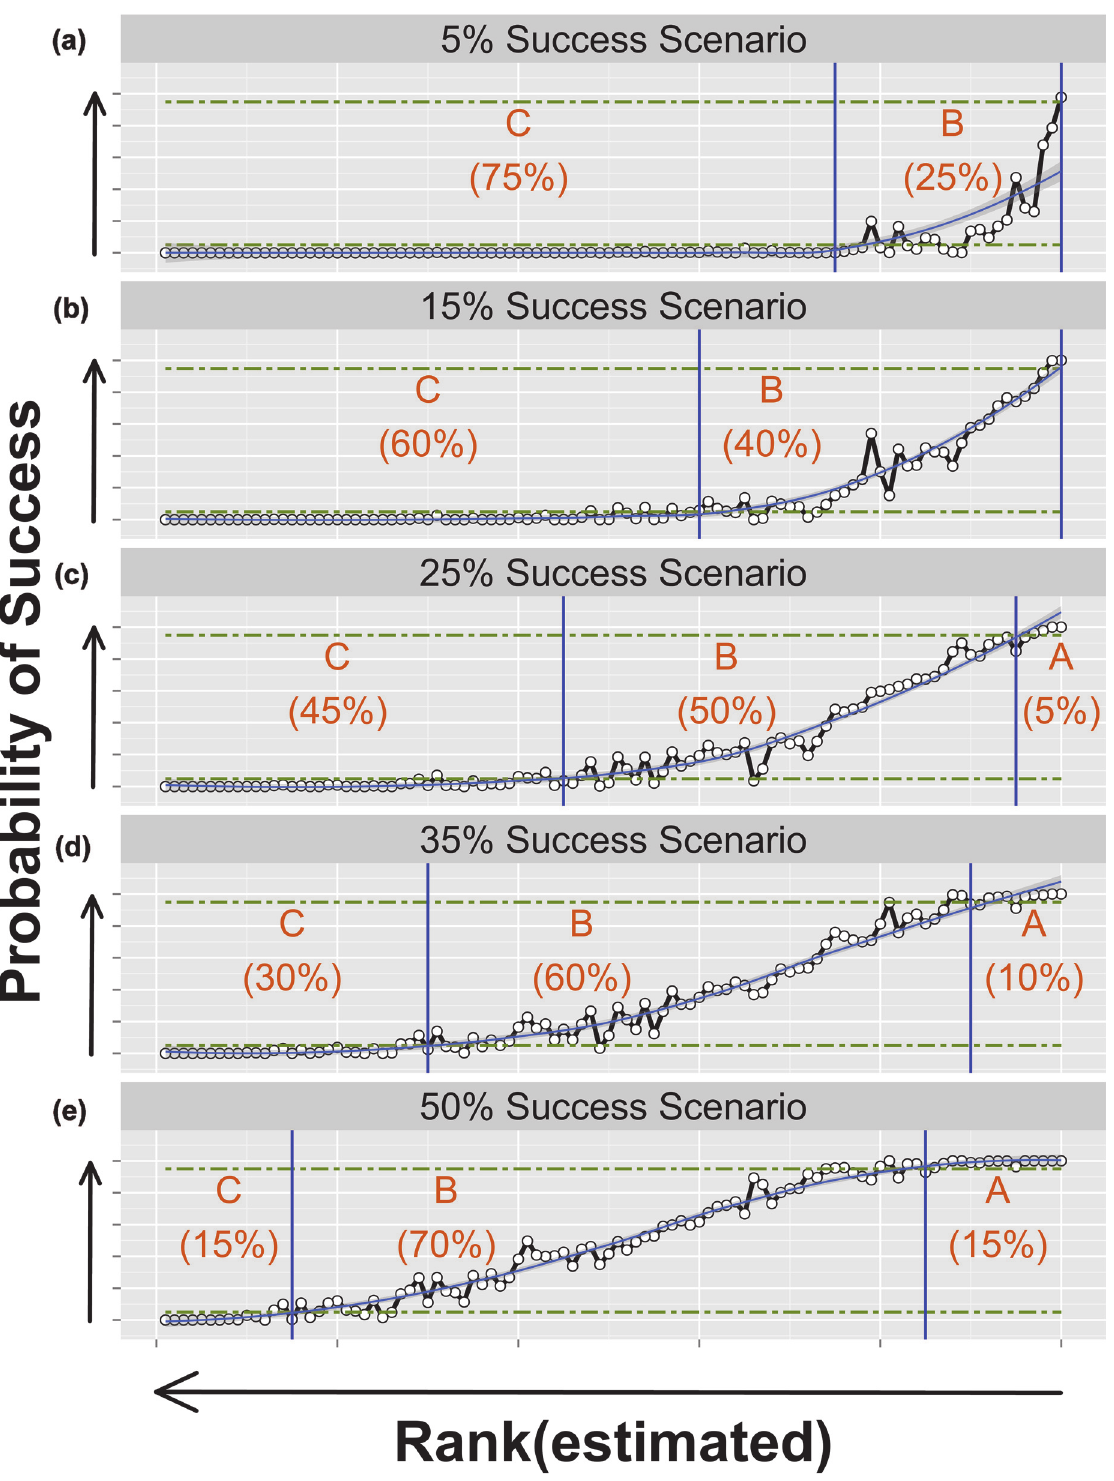
Fig 3. Relative proportion of applications in three outcome categories, in five overall competition scenarios (5 reviewers per application). For 100 applications within five overall competition success scenarios [5% (a), 15% (b), 25% (c), 35% (d), and 50% (e)], different proportions of applications had very high (A), medium (B) or very low (C) probability of success (categories defined in text) over 10,000 iterations of simulated competition results. Horizontal green lines indicated a probability of success of 5% and 95%. Vertical blue lines indicated where locally weighted polynomial regression (LOESS smoothing) curves intersected the 5% or 95% probability of success, or reached the highest ranked application (the limit of the graph). doi:10.1371/journal.pone.0120838.g003 PLOS ONE | DOI:10.1371/journal.pone.0120838 April 1,